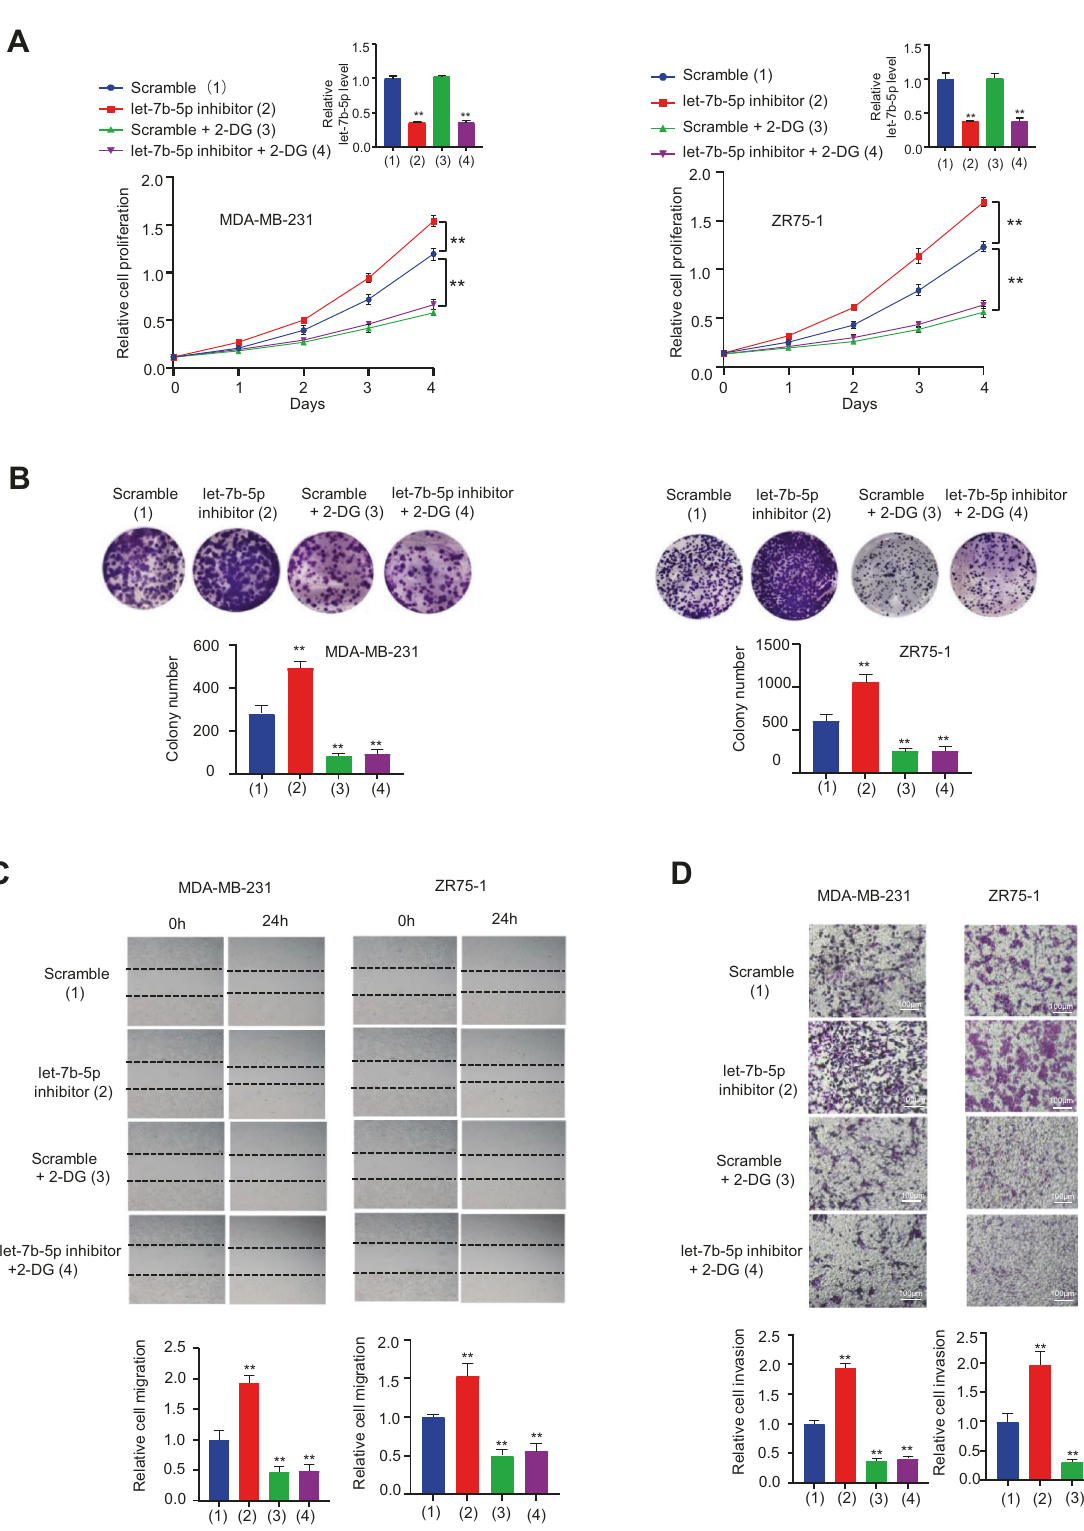
Fig. 5 Let-7b-5p relies on glycolysis to regulate BC cell proliferation and migration. A Growth curve of the indicated BC cells were assayed by CCK-8-kit after the transfection of let-7b-5p inhibitor or scramble and treatment of 2.5 mM 2-DG ( n = 3, mean ± SD). RT-qPCR analyzed let- 7b-5p expression ( n = 3, mean ± SD). B Colony formation assay of the indicated cells after transfection as in ( A ). Histograms display the colony number ( n = 3, mean ± SD). C , D Scratch test ( C ) and transwell assay ( D ) of the indicated cells after the transfection as in ( A ). Histograms display relative cell migration or invasion ( n = 3, mean ± SD). ** p < 0.01 versus corresponding